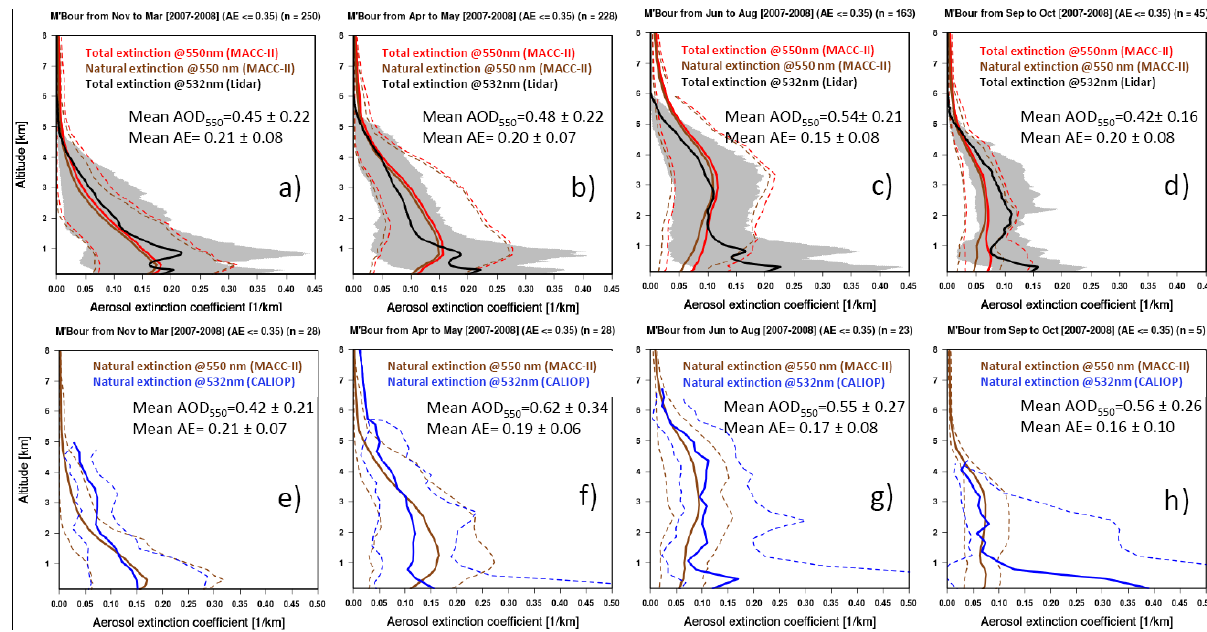
Figure 8. Averaged extinction coefficient vertical profiles obtained with simultaneous extinction profiles simulated with MACC-II and observed by the lidar at M’Bour for those days with mean AE < 0 . 35, for the following periods: November–March (a) , November–May (b) , June–August (c) , and September–October (d) . MACC-II natural extinction corresponds to marine and dust aerosols. The gray shaded area is bounded by the 10th and 90th percentile values of ground-based lidar total extinction at each level. Panels (e–h) are the same as previous ones but using CALIOP extinction vertical profiles. Dashed lines indicate the 10th and 90th percentile values of MACC-II and CALIOP natural extinction at each